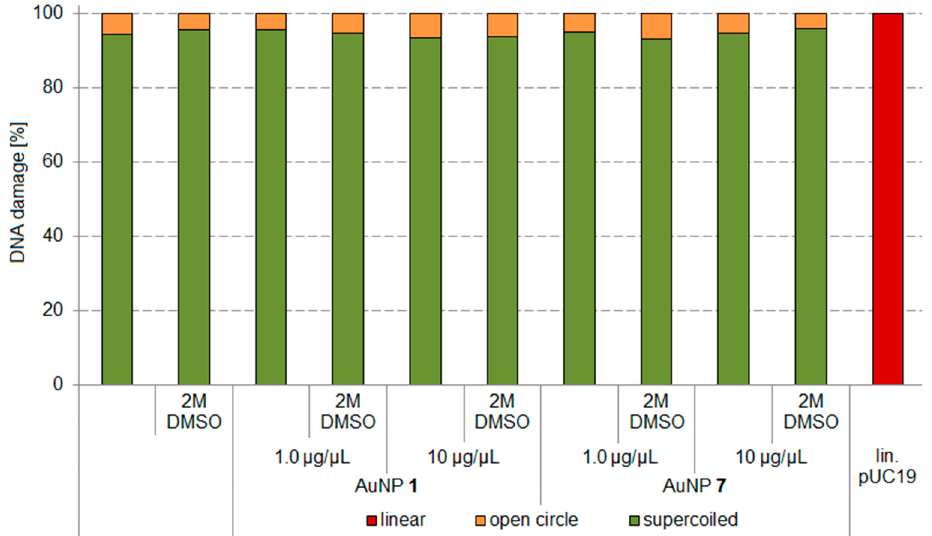
Figure A20. Influence of AuNPs 1 and 7 to the degradation of pUC19 DNA applying different concentrations of 0, 1, and 10 μ g/ μ L with and without 2 M DMSO. sc pUC19 is expressed as green bar, the extent of oc is expressed in orange, and the extent of lin plasmid in red.